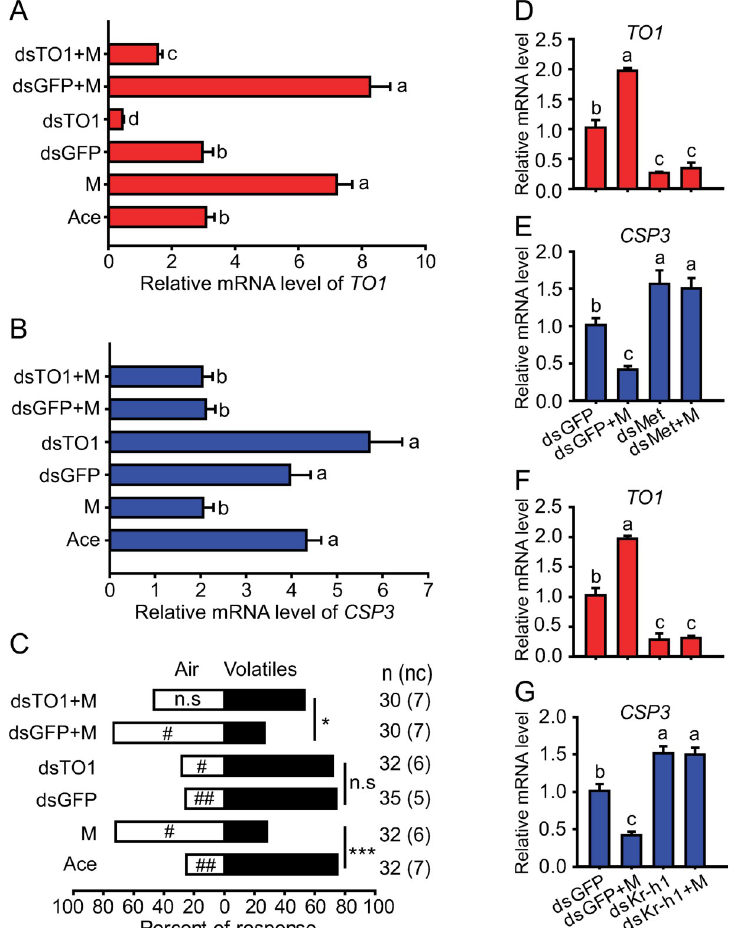
Fig 5. Effects of JH or JH signaling pathway genes on antennal gene expression and choice behavior in gregarious nymphs. (A) Relative mRNA level of TO1 gene after methoprene treatment or injection of ds GFP or ds TO1 combined with methoprene treatment. (B) Relative mRNA level of CSP3 gene after methoprene treatment or injection of ds GFP or ds TO1 combined with methoprene treatment. (C) Choice behavior after methoprene treatment or injection of ds GFP or ds TO1 combined with methoprene treatment. (D and E) Relative mRNA level of TO1 or CSP3 genes after injection of ds GFP or ds Met or rescued by methoprene. (F and G) Relative mRNA level of TO1 or CSP3 genes after injection of ds GFP or ds Kr-h1 or rescued by methoprene. M,